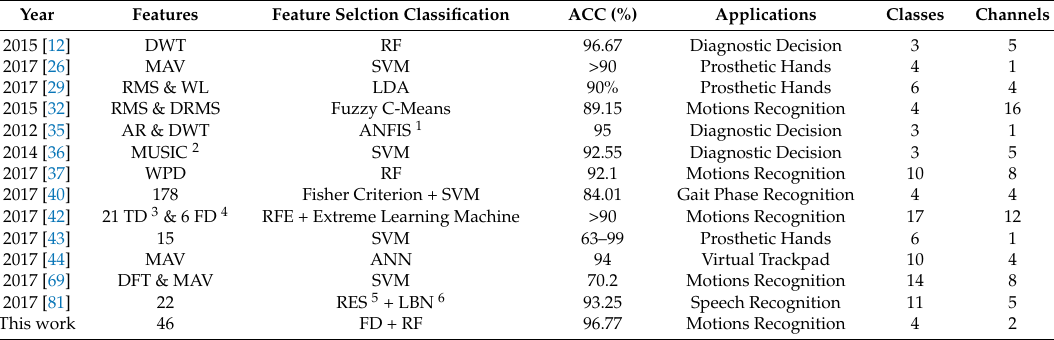
1 ANFIS: the Adaptive Neuro-Fuzzy Inference System. 2 MUSIC: feature extraction using Multiple Signal Classification. 3 TD: Time Domain. 4 FD: Frequency Domain. 5 RES: ratio of Euclidian distance and standard deviation. 6 LBN: Linear Bayes Normal